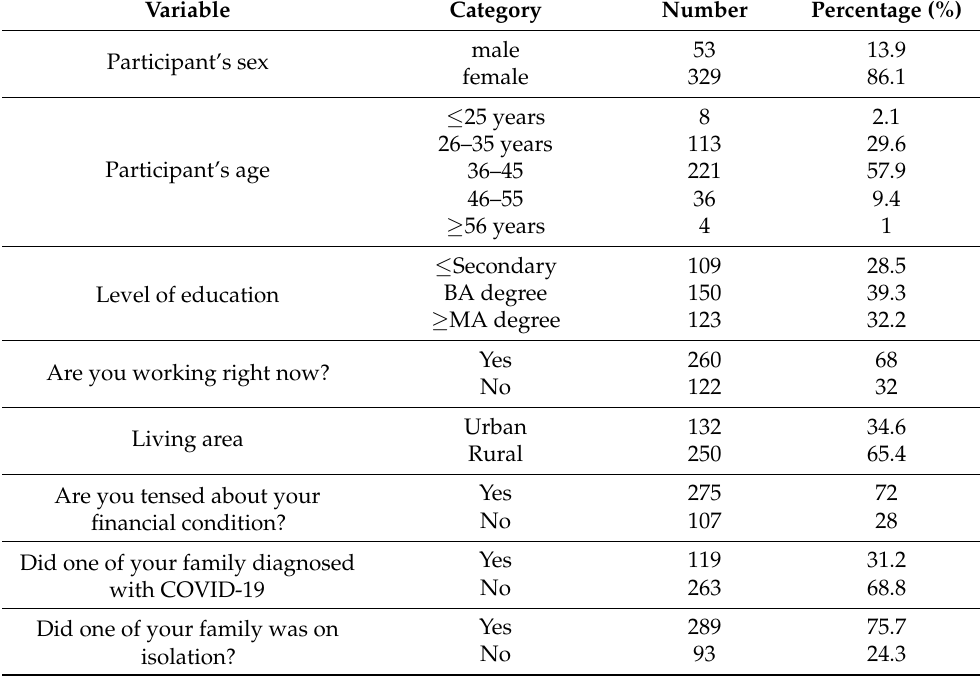
Table 1. Socio-demographic characteristics of parents